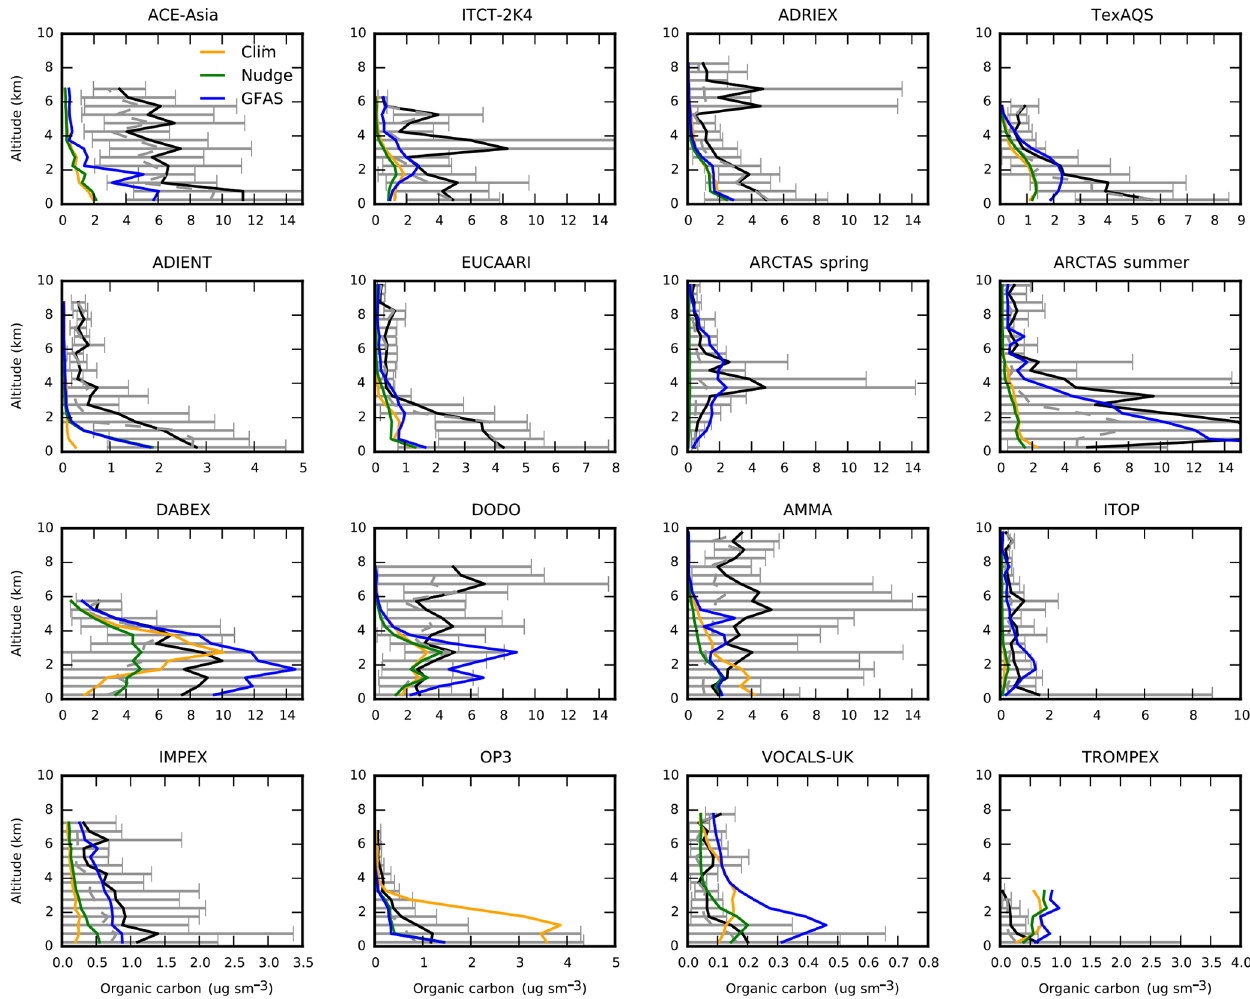
Figure 16. As Fig. 12 for OC aerosol.